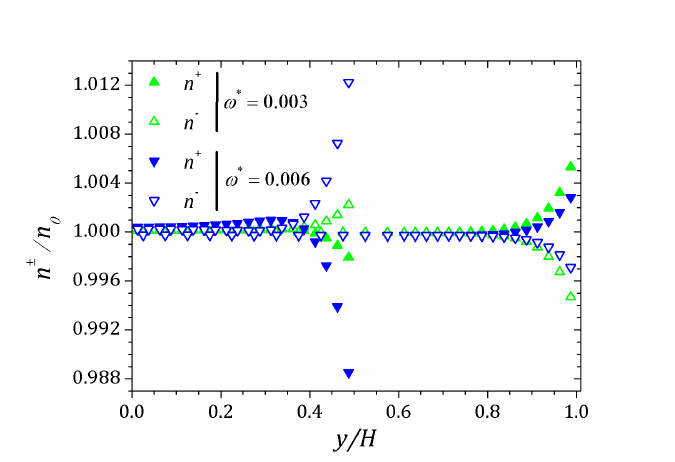
Figure 23. Ionic concentration n ± into the contraction and right after the expansion of the channel.